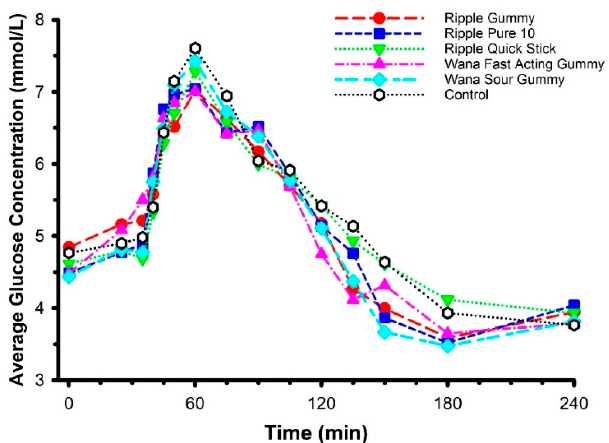
Figure 5. Mean circulating glucose concentrations following ingestion of commercially available edible marijuana (10 mg of THC) and one marijuana-free control product. Seventy-five grams of glucose was ingested at 30 min. Fasting glucose was not different across study sessions ( p = 0.40). Circulating glucose was not different from fasting glucose 30 min after product ingestion ( p = 0.88). Compared with placebo, none of the edible marijuana products influenced circulating glucose throughout each of the trials (product × time interaction p = 0.98). Error bars have been omitted for clarity.